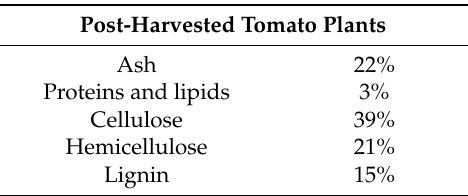
Table 2. Composition of biomass (wt